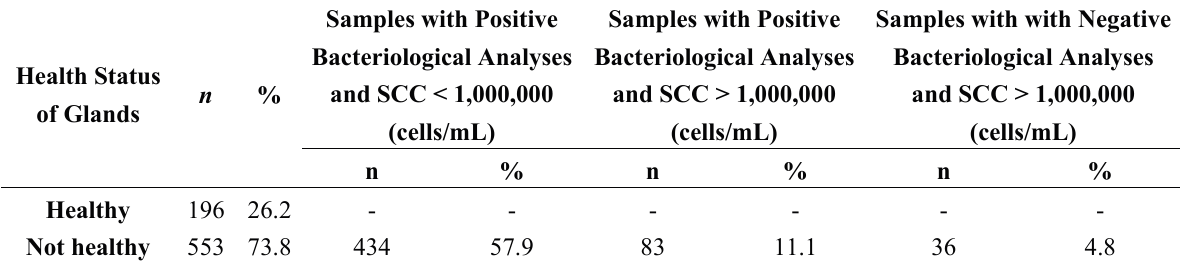
Table 3. Distribution of mammary glands for each health status considered. Samples were classified as collected from healthy glands when somatic cell counts were less than 1,000,000 cells/mL and pathogens were absent, and classified as collected from NH mammary glands when bacteriological analyses were positive for IMI or SCC were more than 1,000,000 cells/mL.